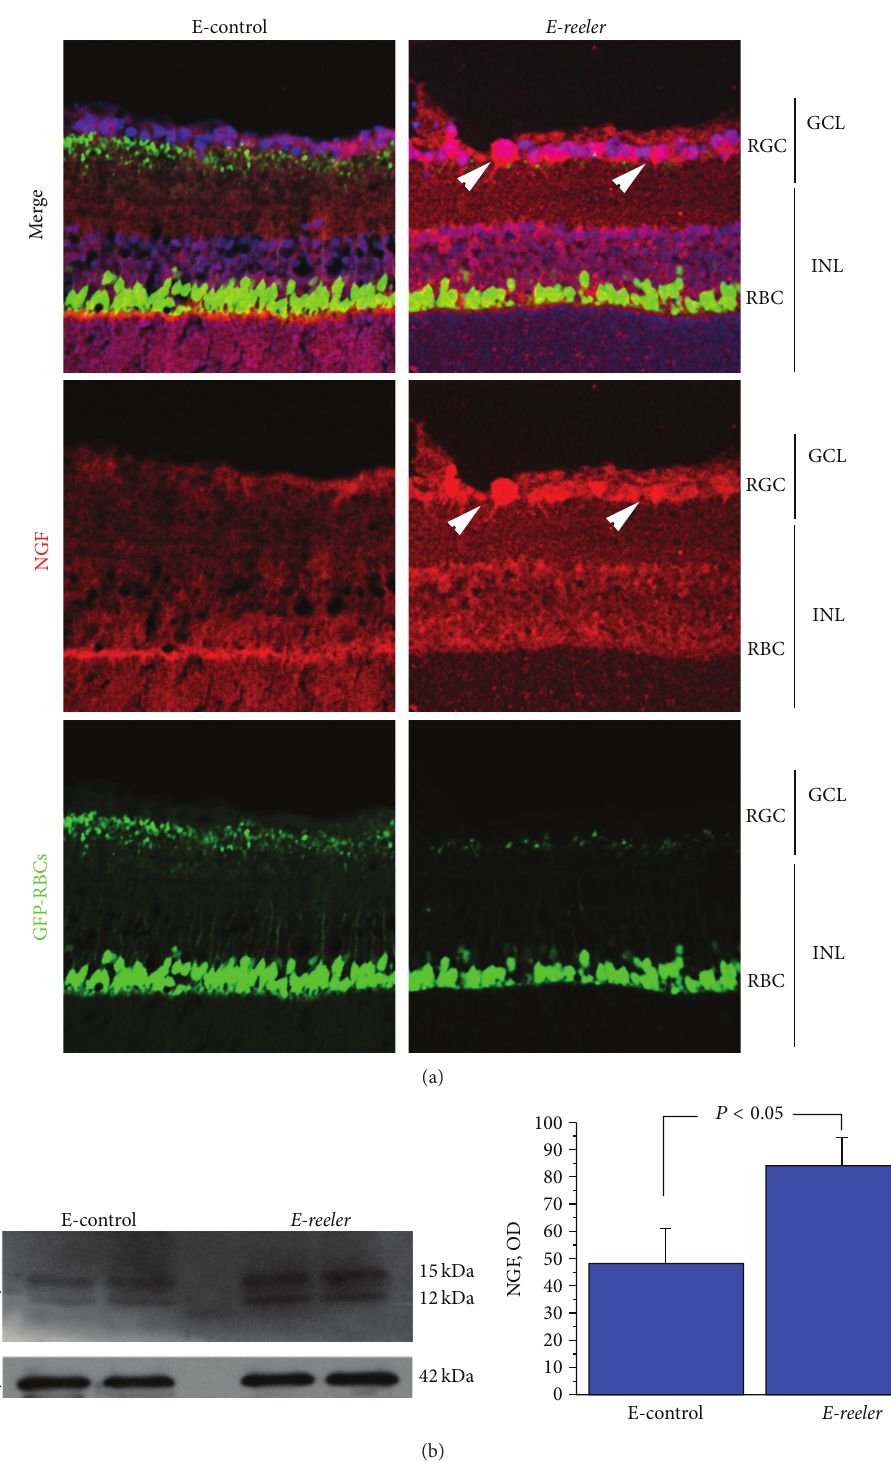
Figure 2: Expression of NGF in E-reeler retina. (a) Confocal microscopy showing images of GFP-expressing RBCs (green), NGF immunoreactivity (red), and nuclear staining (blue). As indicated by arrowheads, in the merge and NGF single staining, INL cells strongly immunoreacted with the NGF antibody. Some immunoreactivity was also observed in other structural and accessory cells ( × 400). (b) Representative 12% SDS-PAGE and relative densitometric analysis of E-control and E-reeler retinal extracts probed with the NGF antibody (OD values; 𝑃 < 0.05 ). The size-marker was run between the two groups. Abbreviations: GCL, Ganglion Cell Layer; INL, Inner Nuclear Layer; RGCs, Retinal Ganglion Cells; RBCs, Rod Bipolar Cells; GFP, Green Fluorescent Protein; OD, Optical